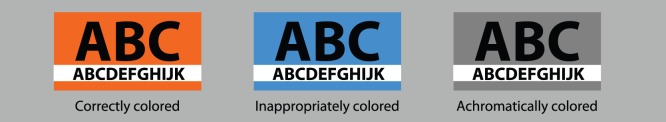
Illustrations for correctly, inappropriately colored and achromatic stimuli of the logo used in the semantic priming task.